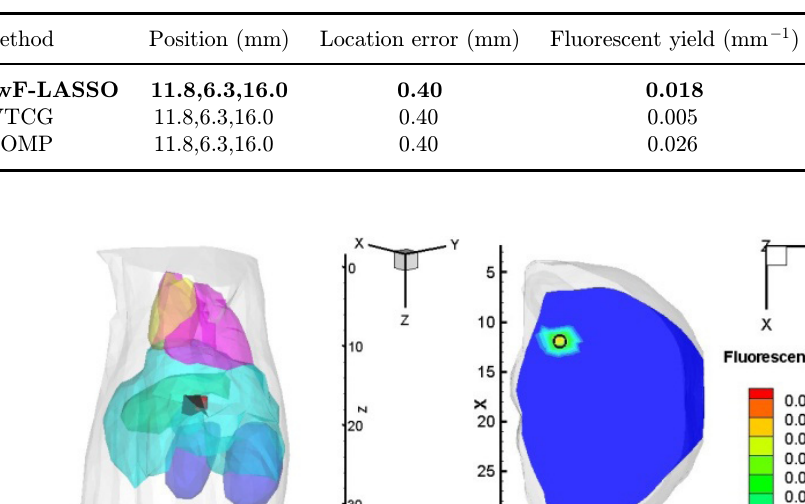
Table 2. Result for single target reconstruction.